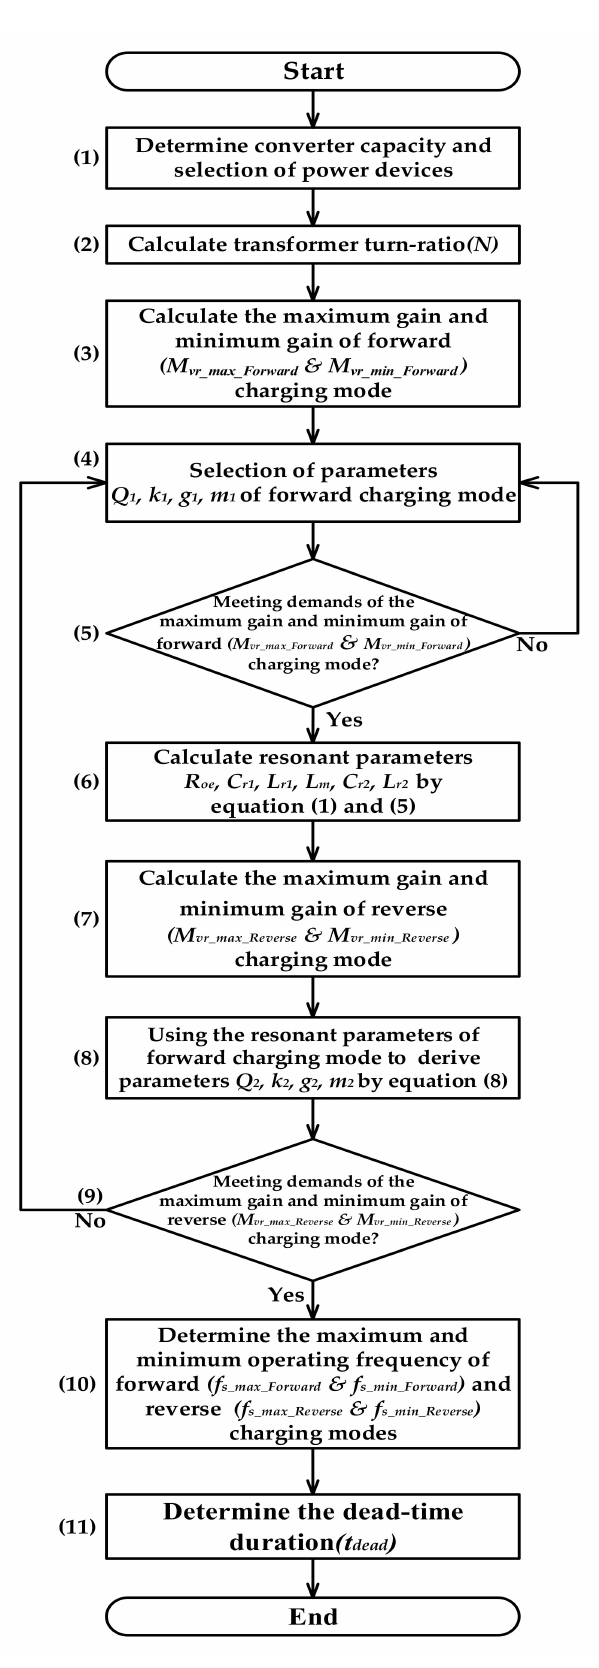
Figure 9. The design flowchart of bidirectional symmetric resonant